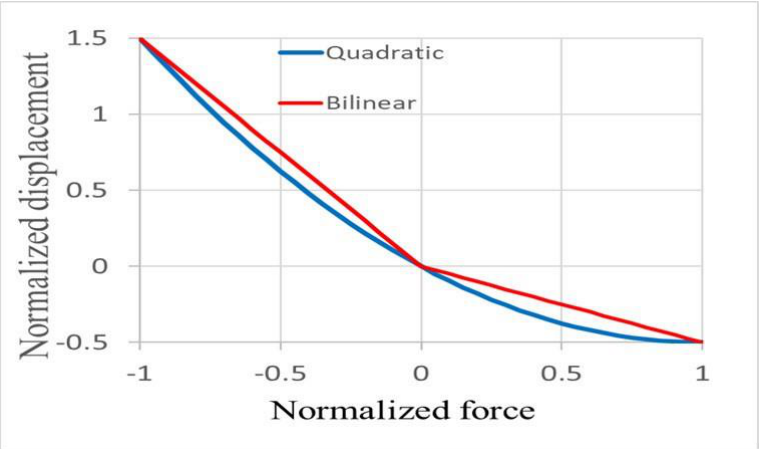
Figure 12. Examples of bilinear (red line) and quadratic (blue line) force–displacement spring relationship. The nonlinear parameter here is 𝛼 = 0.5, which is much larger than for the considered case.